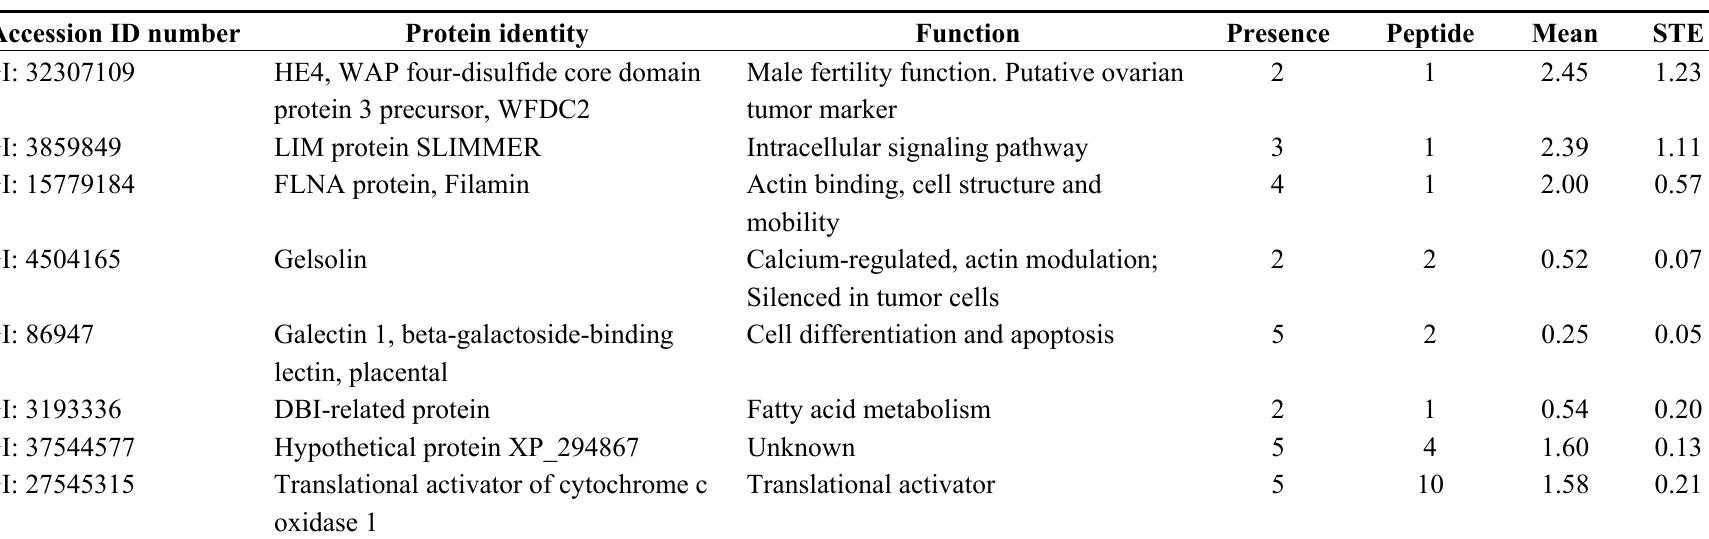
Table 1. Representative proteins identified by Isotope-Coded Affinity Tag (ICAT)-mass spectrometry. The table provides basic information on accession number (GI number is NCBI/PubMed protein ID number), protein identity, cellular function, numbers of paired-samples in which the protein was detected (Presence), the average ratio between endometrioid cancers and normal controls (Mean), and the standard errors